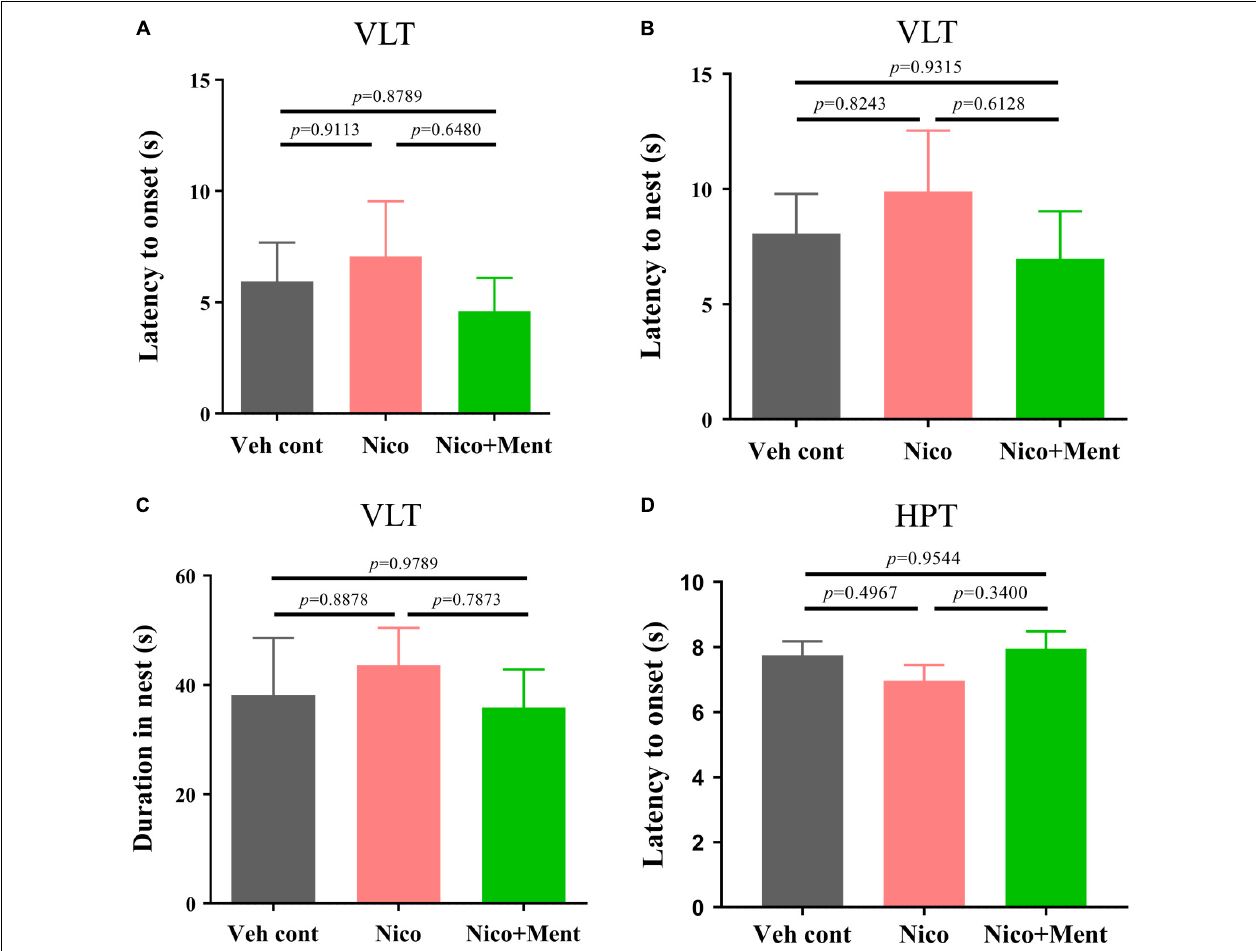
FIGURE 5 | The innate visual or perceptual behavioral assessment in mice after long-term ENDS exposure. The behavioral tests were performed in order during ENDS exposure as described in Figure 2B . (A) The latency to the onset behavior of mice during the Visual looming test (VLT; s) [ F ( 2 , 21 ) = 0.4033, p = 0.6732]. (B) The latency of flight to the nest behavior of mice during VLT (s) [ F ( 2 , 21 ) = 0.4649, p = 0.6345]. (C) Duration of mice hiding in the nest (s) [ F ( 2 , 21 ) = 0.2317, p = 0.7952]. (D) The latency to the onset behavior of mice during the Hot-plate test (s). The value of * p < 0.05 as determined by ordinary one-way ANOVA and multiple comparisons with every other group. Bars represent marginal means ± SEM. N = 8 per group. Veh cont, Vehicle control; Nico, Nicotine; Nico + ment, nicotine with menthol